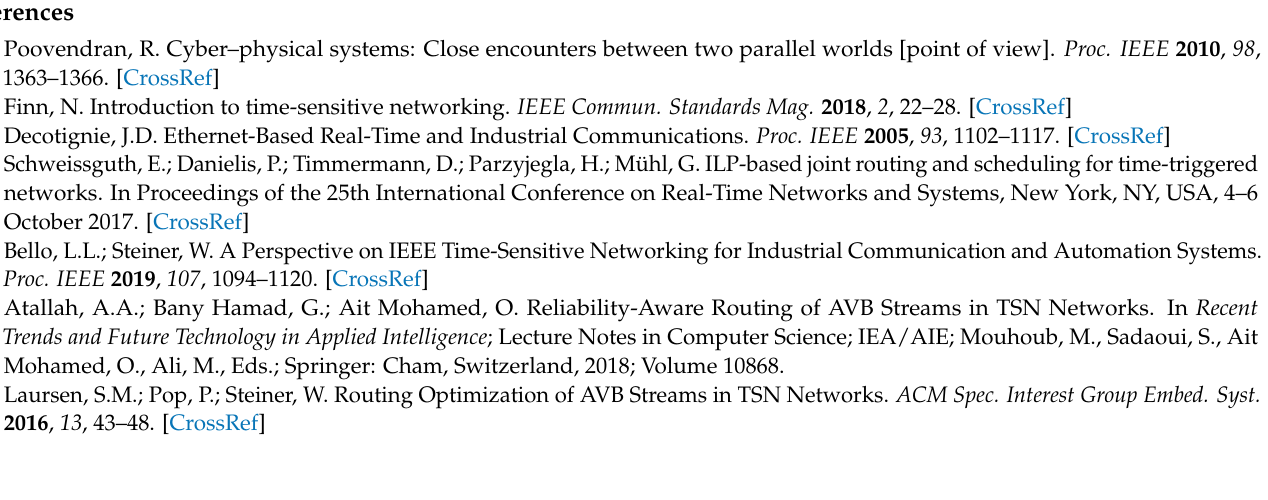
Figure 14. Schedulability trend with threshold changes in Topology 2.